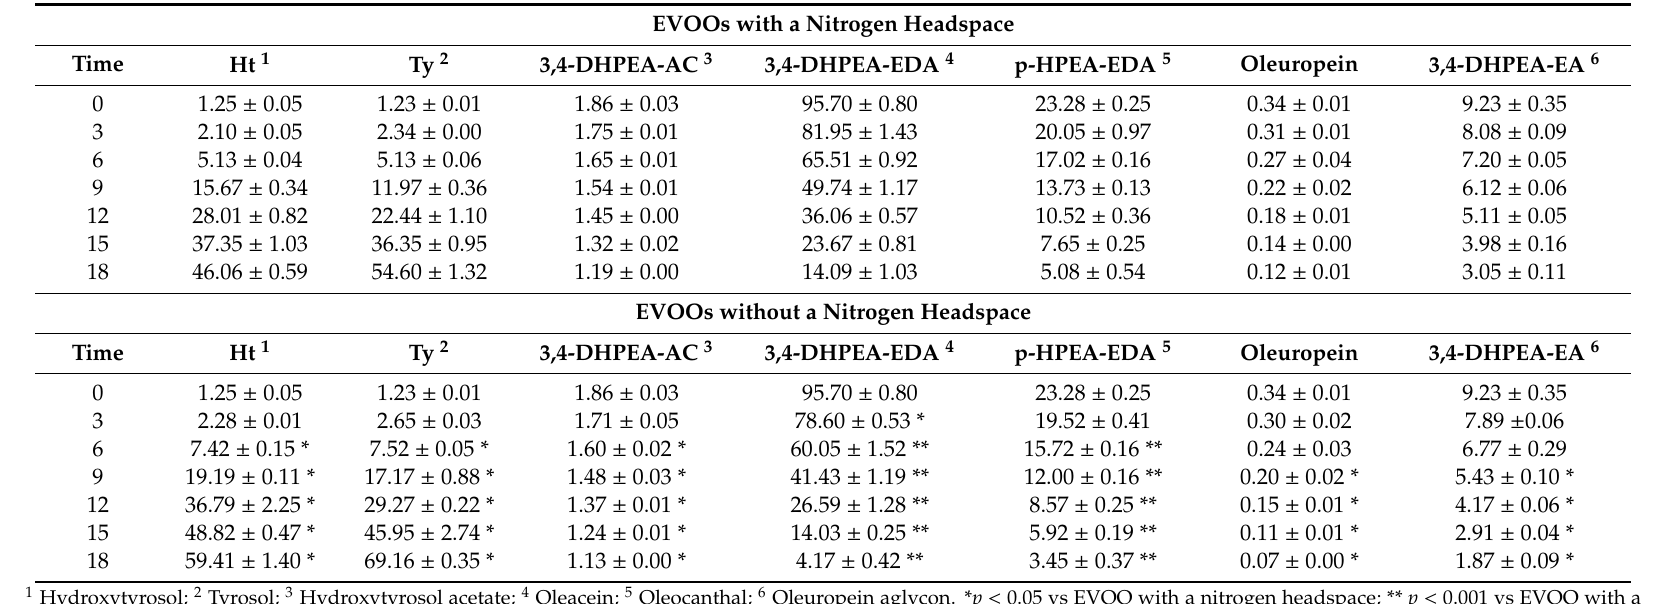
Table 3. Hydroxytyrosol, tyrosol and secoiridoids modifications (mg kg − 1 ) during storage time (0–18 months) of EVOOs with and without a nitrogen headspace. EVOOs with a Nitrogen